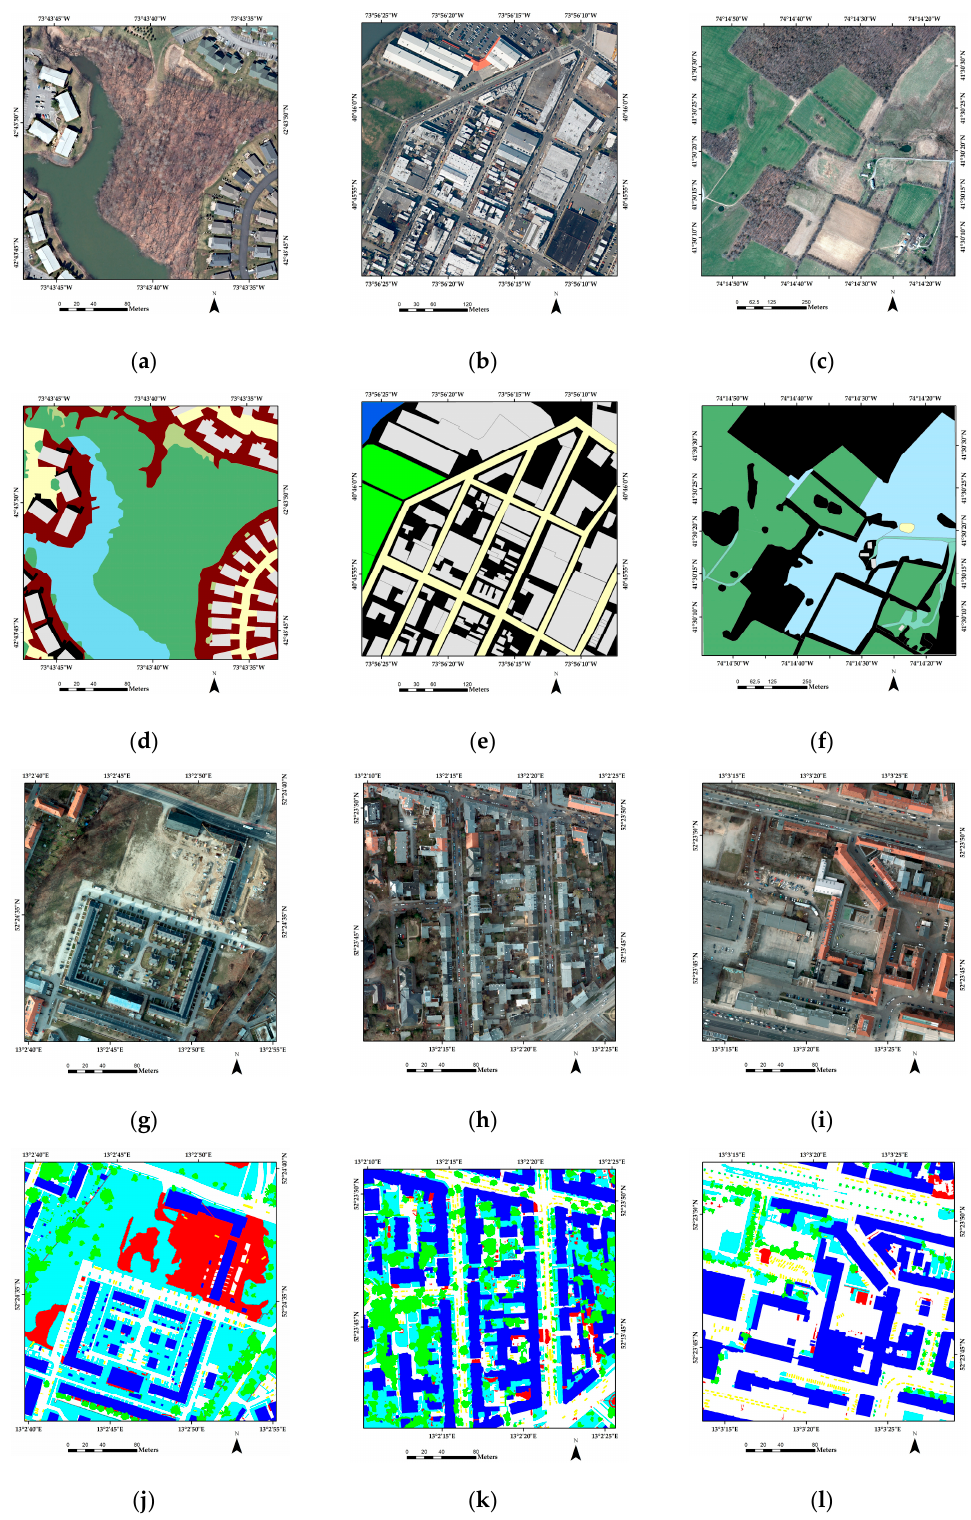
Figure 7. Experimental high spatial resolution (HSR) images. ( a ) T1, Albany QuickBird image; ( b ) T2, Manhattan, Aerial image; ( c ) T3, Montgomery Aerial image, false-color; ( d – f ) are the ( a – c ) corresponding benchmark vector polygons; ( g ) T4, Potsdam Aerial image; ( h ) T5, Potsdam, Aerial image; ( i ) T6, Potsdam Aerial image, false-color; ( j – l ) are the ( g – i ) corresponding benchmark vector